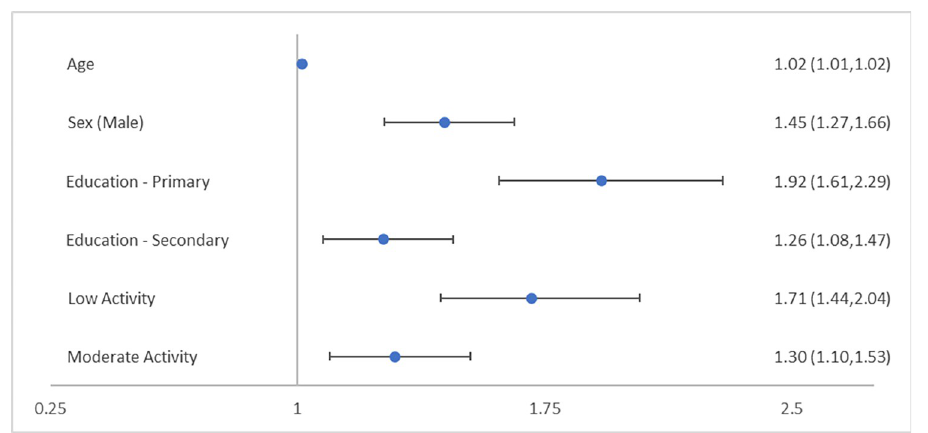
Fig 2. Categorisation of wave 1 TILDA participants by ATPIII metabolic syndrome (MetS) criteria to estimate odds ratio (95% confidence intervals) for likelihood of MetS. Third level and higher the base reference for education and high levels of physical activity the base reference for physical activity.